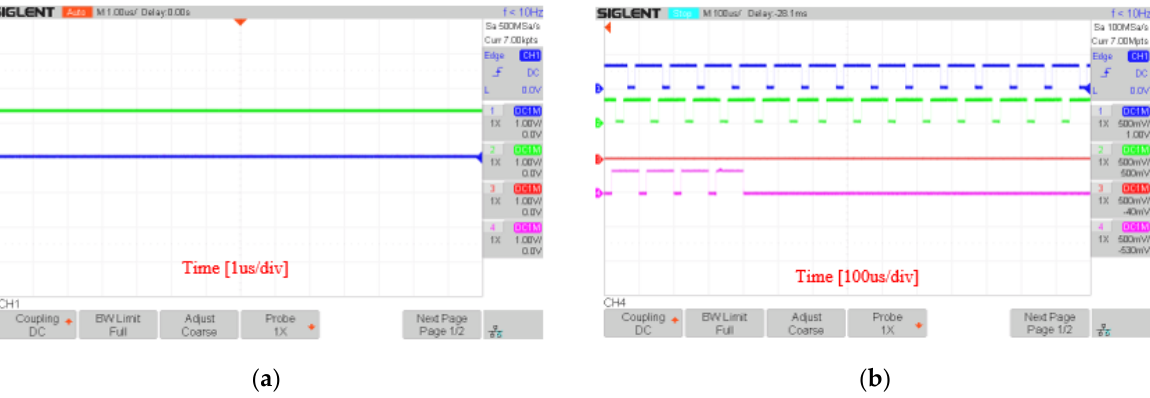
Figure 33. Experimental result of two interleaved carriers using DSA-PSC method, ( a ) carrier phases; ( b ) PWM control